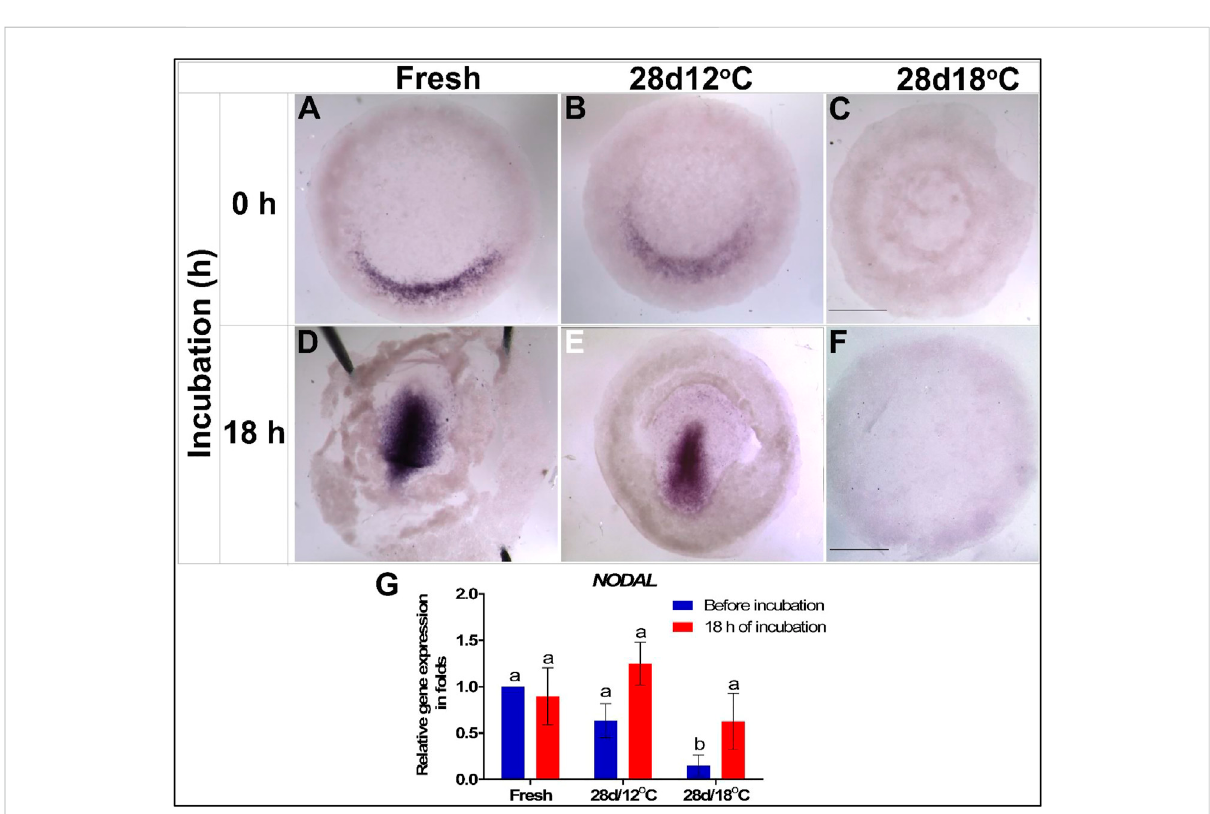
FIGURE 4 Expression of NODAL gene in embryos following storage, and following 18 h of incubation in the resumption phase. (A – C) NODAL gene expression in freshly laid (X EG&K), 28 days/12 ° C (XII EG&K), and 28 days/18 ° C (1 H&H) stored embryos, respectively. (D – F) Expression pattern of NODAL following 18 h of incubation, in freshly laid (3 H&H), 28 days/12 ° C (3 H&H), and 28 days/18 ° C (1 H&H) stored embryos, respectively. (G) Quanti fi cation of NODAL gene expression in 6 different embryo groups using real-time PCR. GAPDH was used for gene expression normalizationand thedetermined NODAL expression inthe groupsis represented as afold ofchange relative to thefresh control. One-way ANOVA analysis of 6 different embryo groups-different connecting letters denote that the expression of NODAL is signi fi cantly different between groups; F value = 7.913; Fresh (before incubation) vs. 28days/18 ° C (before incubation), a vs. b: p = 0.001; 28 days/12 ° C (before incubation) vs. 28 days/18 ° C (before incubation), a vs. b: p = 0.0098; 28 days/18 ° C (before incubation vs. after incubation), a vs. b: p = 0.025. Bar = 1